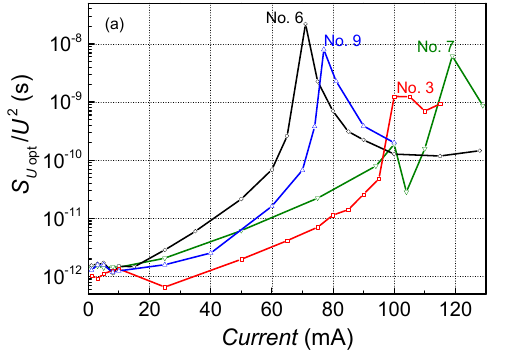
optical and electrical fluctuations in the 10 Hz–20 kHz frequency range ( b ) dependencies on forward Figure 7. Normalized optical noise spectral density at 108 Hz ( a ) and cross-correlation between